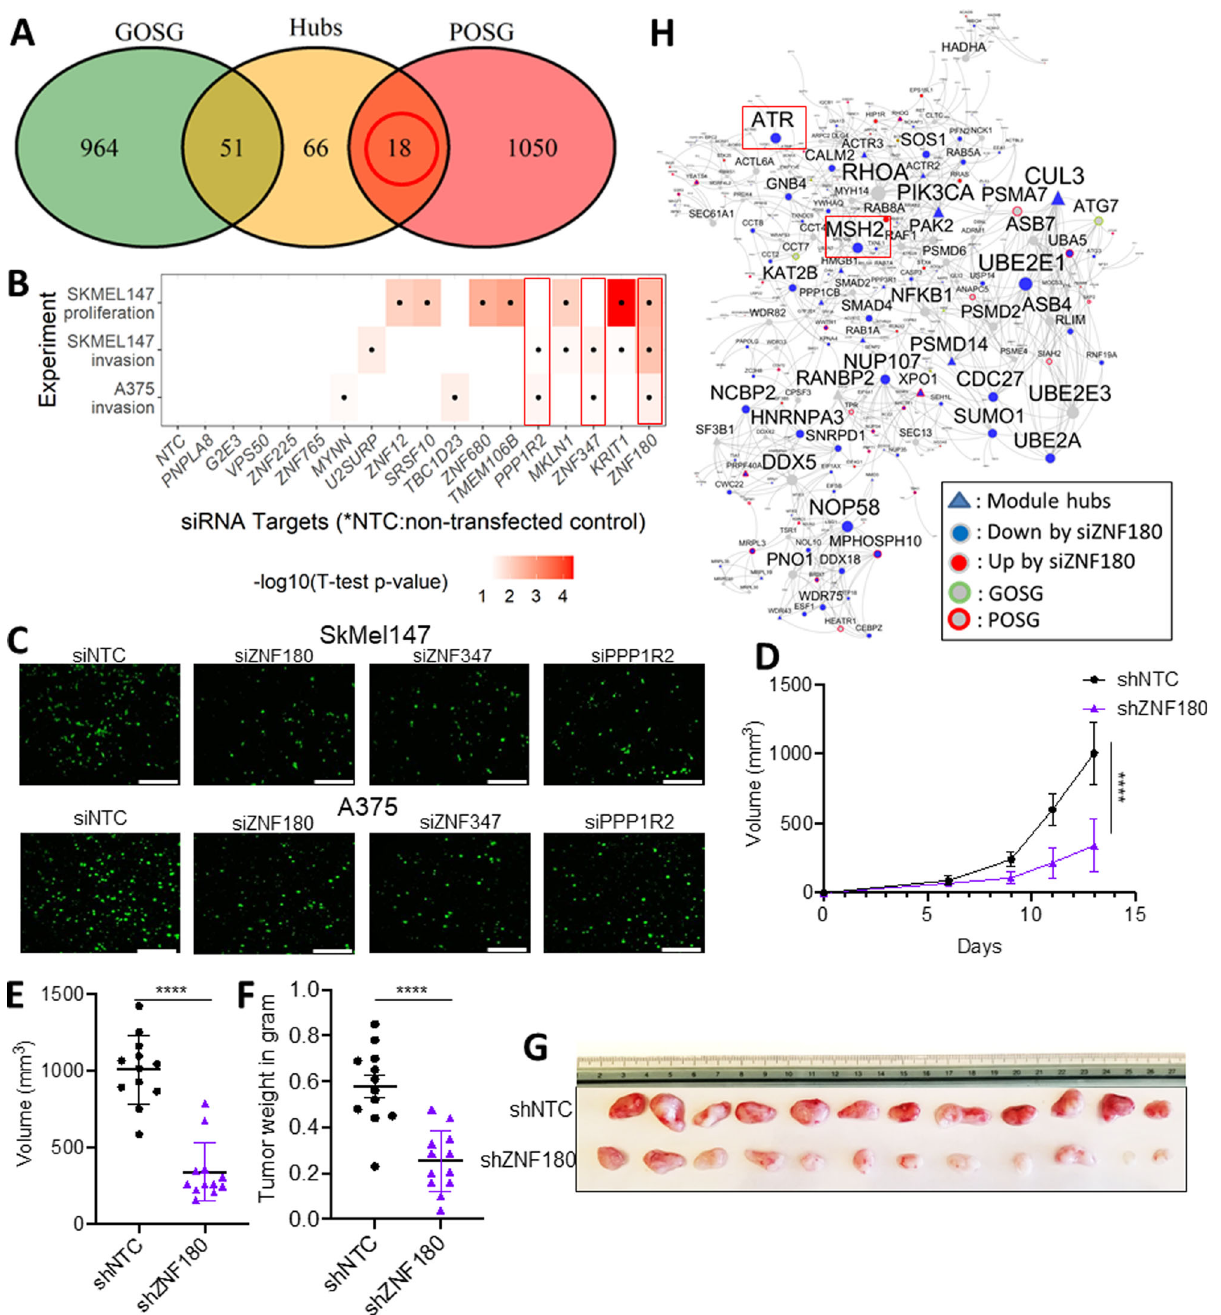
Fig. 3 Systematic identi fi cation and validation of ZNF180 as a promising target in primary melanoma. A Intersections between the poor survival gene signature from pSKCM (pSKCM-POSG), and the good survival gene signature (pSKCM-GOSG), and the hubs of the top ten modules. Eighteen hub genes which are also pSKCM-POSG were nominated for siRNA screenings. B siRNA screening of the nominated targets for proliferation in (top) and invasion (middle) in SKmel147, and invasion in A375 cells (bottom). The heatmap shows − log10( t test p value) to remark the signi fi cance of the siRNA screening results, and signi fi cant results are marked by dots. Red rectangles highlight consistently validated genes ( ZNF180 , ZNF347 and PPP1R2 ). C Trans-well matrigel invasion assays on SKmel147 and A375 cells transduced with siNTC or siZNF180, siZNF347, and siPPP1R2. Invading cells were quanti fi ed by counting the number of SKmel147 and A375 cells that invaded into the basal side of Matrigel-coated trans-well inserts after 8 and 6 h respectively, n = 5 fi elds per replicate; 3 replicates per condition, representative images are shown. Scale bar corresponds to 100 µ m. D Growth curve representing average tumor volume over time in mice injected with shNTC or shZNF180-transduced SKmel147 cells ( n = 12 per group). Tumor volume ( E ) and tumor mass ( F ), and ( G ) images of resected tumors taken 13 days post injection. Data are presented as mean ± SD in ( D – F ). **** denotes signi fi cance of the comparison by two-tailed unpaired t test by p < 0.0001. H M25 captures protein interactions curated in the STRING database with a con fi dence score >70%. Node colors and border colors denote differentially expressed genes by siZNF180 (siZNF180-DEG) and pSKCM survival signatures as shown in the legend.